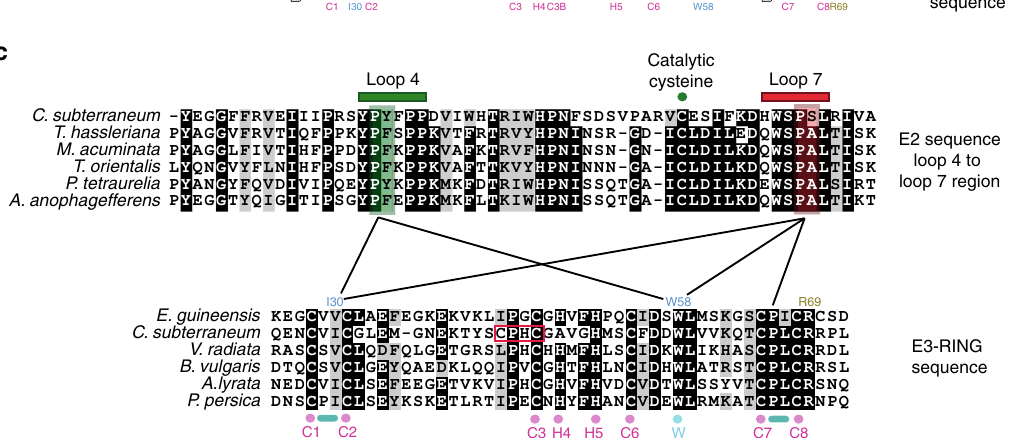
Fig. 5 Structural prediction of the canonical RING-domain crossbrace arrangement of the C. subterraneum srfp (E3) protein. a (left top) schematic representation of the RING-domain cross-brace structure with the zinc-coordinating residues circled in red; (left bottom) consensus sequence of the RING- domain (RING-H2 family) with zinc-binding residues highlighted in red ( ‘ X ’ any residue); (middle top): RING-domain of the Homo sapiens RING-E3 ubiquitin ligase praja-1 (PDB: 2L0B); (right top): I-TASSER model of the C. subterraneum srfp (E3-like) homologue. Zinc-binding residues are coloured pink (with carbon and sulphur atoms in blue and yellow, respectively) and a conserved tryptophan coloured blue. Green spheres denote Zn 2+ ions. Loops that interact with conserved residues in the E2-enzymes are coloured blue. b Schematic predicting contacts between residues in the C. subterraneum RING domain and the E2-like enzyme loops 4 and 7 based upon conservation of residues in eukaryotic components 21, 22, 41, 44 . Zinc-coordinating residues are coloured red; the conserved tryptophan and the hydrophobic residues presented on loops in the RING domain are coloured blue. Key conserved hydrophobic residues on the E2-like enzyme (PY or PS on loops 4 or 7, respectively) are indicated. c Multiple sequence alignments of the C. subterraneum E2-like and E3-like protein amino-acid sequences with the closest eukaryotic homologues also indicating the speci fi c E2/E3 interactions shown in b . E2-ubiquitin-conjugating homologues: ( Paramecium tetraurelia [Alveolata ciliate], Musa acuminata [banana], Aureococcus anophagefferens [alga], Tarenaya hassleriana [spider fl ower], Theileria orientalis [Apicomplexan parasite]). E3-RING homologues: ( Elaeis guineensis [oil-palm], Vigna radiata [mung bean], Beta vulgaris [sugar beet], Arabidopsis lyrata [rockcress], Prunus persica [peach]). The conserved motifs on loops 4 and 7 of the E2-like enzymes are represented by green and red bars, respectively. The catalytic cysteine is denoted by a green circle. The E3-like zinc-binding cysteines and histidines are highlighted by purple circles. Note that the position of the C. subterraneum C3 and H4 are out of alignment by 2 residues (red box). The conserved tryptophan (blue circle) and hydrophobic interaction interfaces between cysteines C1 and C2 and C7 and C8 (blue bars) are also highlighted. The position of residues I30, W58 and R69 are also indicated. Structural fi gures were prepared using